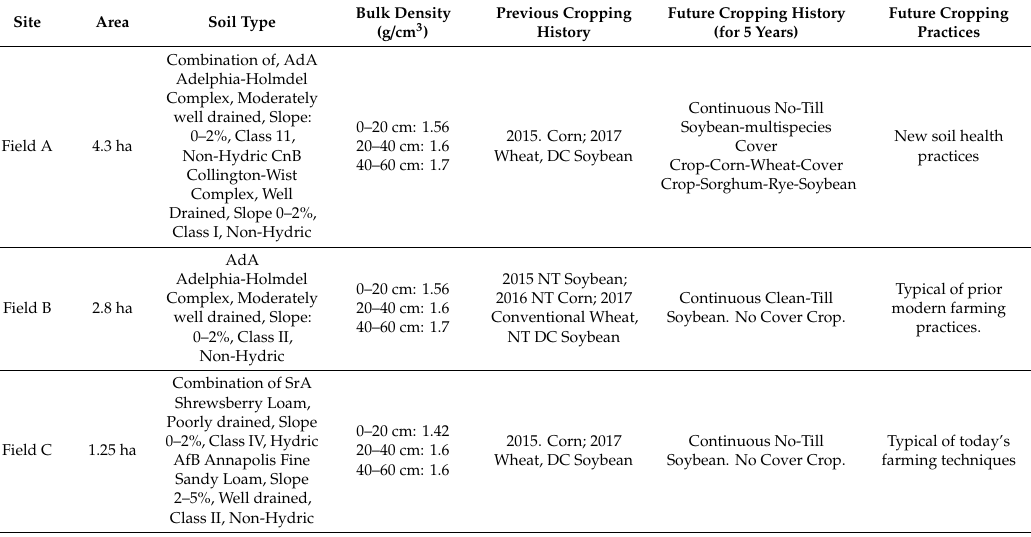
Table 1. Current and proposed management practices and soil physical characteristics of three field